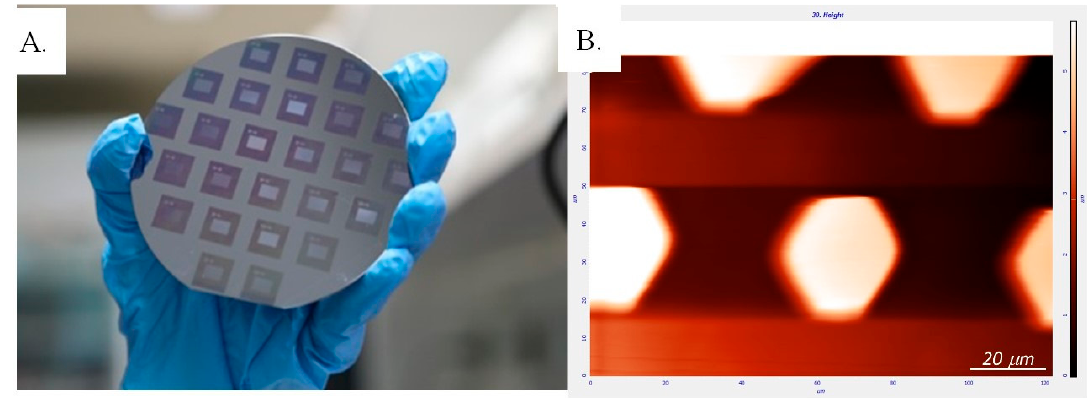
Figure 4. Introduction of hexagonal micropillars onto the PDMS/GO + GO scaffold. ( A ) The wafer molds used to generate the hexagonal micropillar pattern on the scaffolds. ( B ) Atomic force microscopy (AFM) image of PDMS/GO + GO membrane demonstrating the regularly arranged hexagonal micropillars (light areas) lining up on the back side of the PDMS membrane with approximately 5 μ m height.